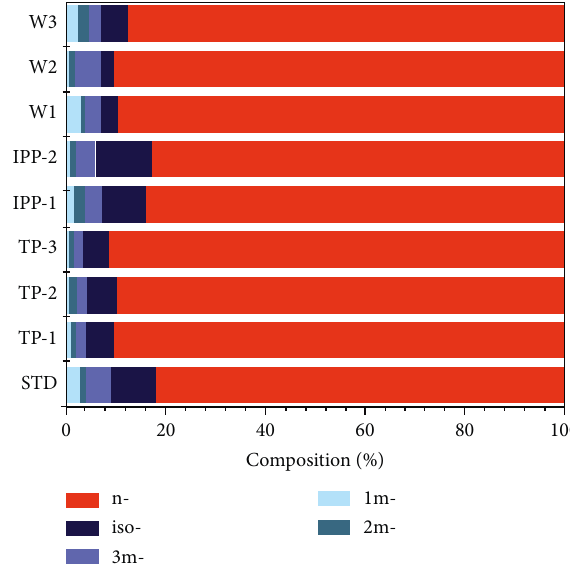
Figure 6: Comparison of compositions of PFHxS isomers in a standard (STD) from Wellington, three PFHxS technical products (TP-1, Bidepharm; TP-2, CNW; TP-3, J&K Scientific), two